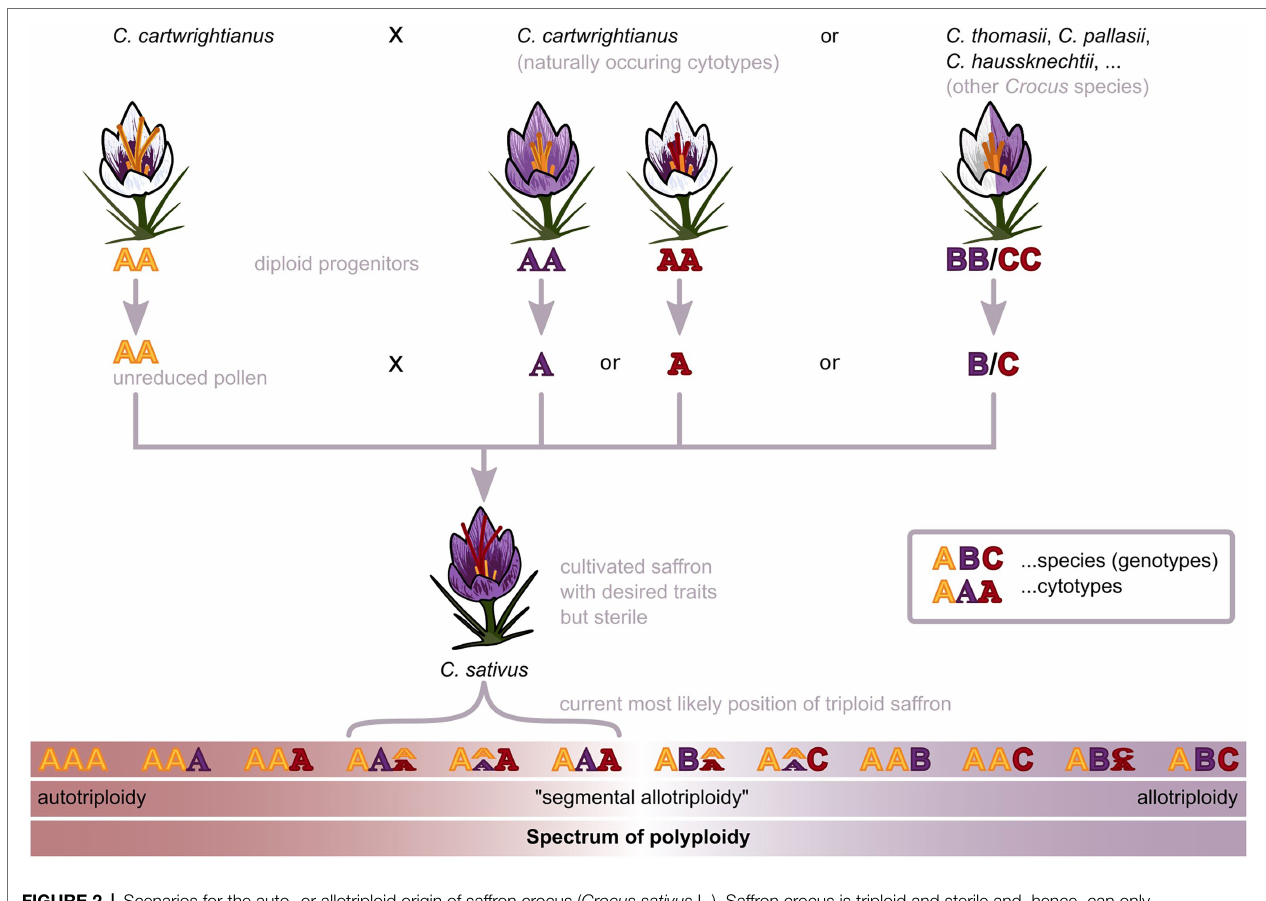
FIGURE 2 | Scenarios for the auto- or allotriploid origin of saffron crocus ( Crocus sativus L.). Saffron crocus is triploid and sterile and, hence, can only be propagated vegetatively through corms. How this triploidy emerged has been debated for over a century, with two main hypotheses being brought forward: On the one hand, saffron may have originated with genome contributions from a single species, likely Crocus carthwrightianus (autotriploid scenario). On the other hand, at least two species may have contributed to the genome of saffron crocus, with one likely being C. cartwrightianus (allotriploid scenario). Both scenarios represent extreme cases along a gradual spectrum from auto- toward allopolyploidy, as indicated by the gradual arrangement in the figure. The current position of saffron supported by several recent studies tends to be more on the autotriploid side of the spectrum of polyploidy (Nemati et al., 2019; Schmidt et al., 2019). The capital letters represent sub-genomes from different species, with different cytotypes being represented by different typefaces. The representation of the spectrum of polyploidy using letter triplets only serves as symbolic visualization and may not represent all possible